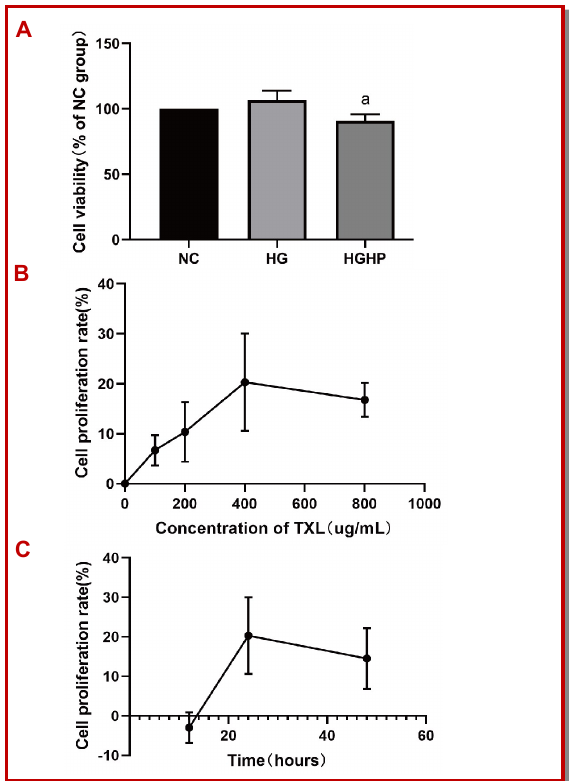
Figure 4: Tongxinluo (TXL) protects HK-2 cells from high- glucose combined with high-palmitic acid (HGHP) injury. Effects of high-glucose (HG) and high-glucose combined with high-palmitic acid (HGHP) on the cell viabilities of HK-2 cells (A); Effects of different concentrations of Tongxinluo on the cell viabilities of HK-2 cells cultured in HGHP 24 hours (B); Effects of different treatment time of 400 µg/mL Tongxinluo on the cell viabilities of HK-2 cells cultured in HGHP (C) . NC means normal